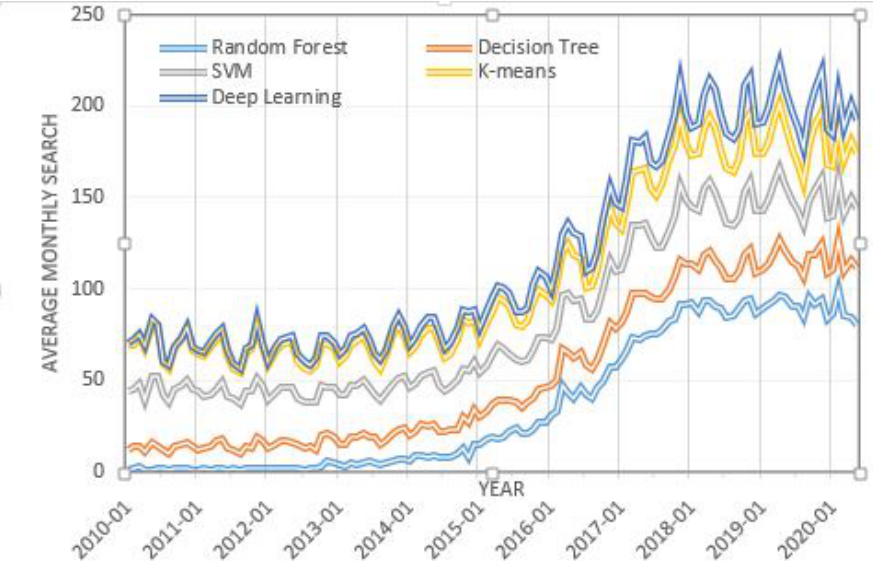
Figure 2. Google trend shows more interest on DL in recent years.